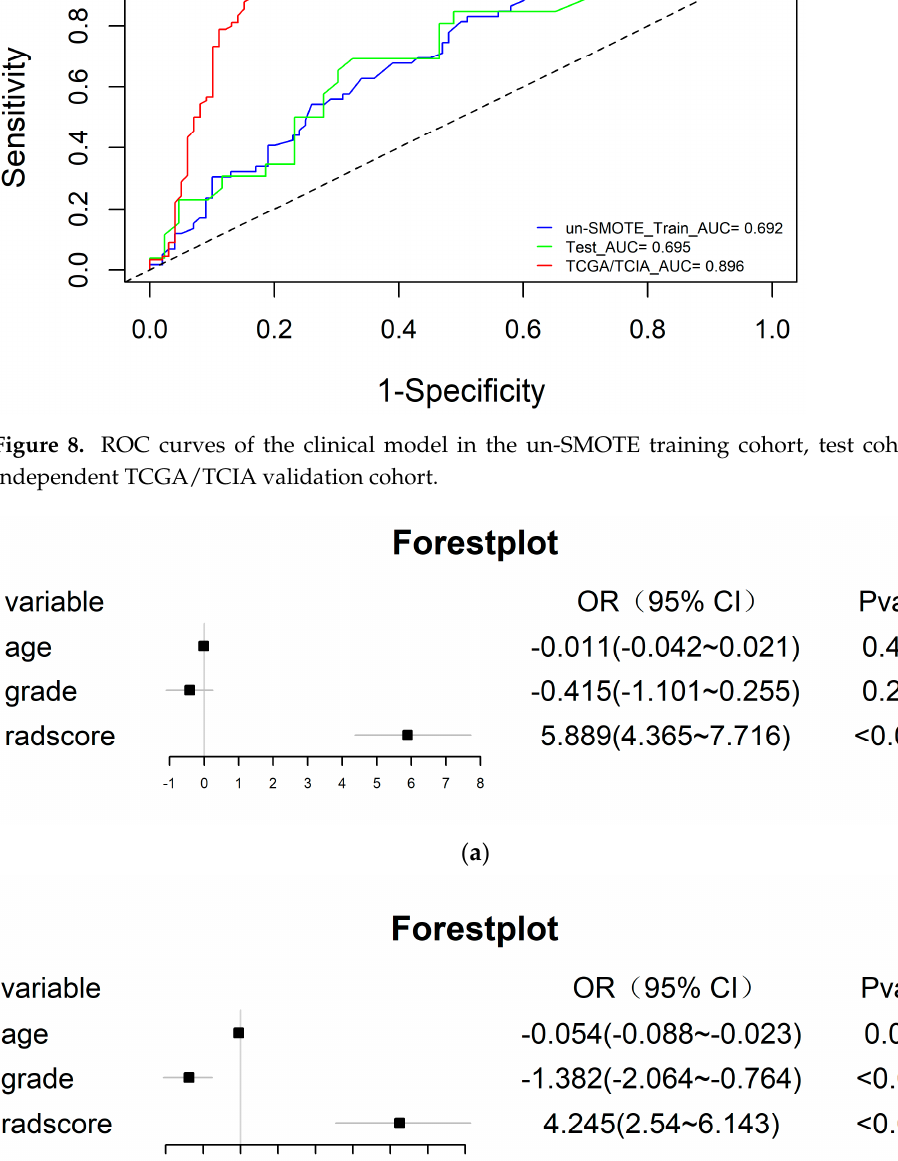
Figure 9. All features of the radiomic–clinical combined model, and the OR value and its 95% CI and p value of each feature. ( a ) Training cohort. ( b ) TCGA/TCIA independent validation cohort.